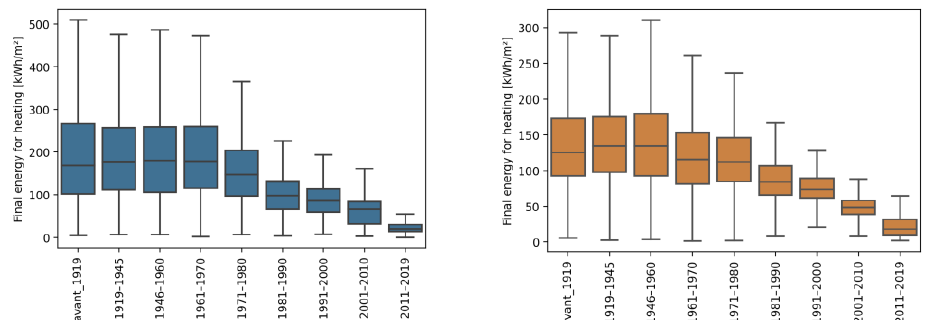
Figure 6. Spread of the final energy for heating of single-family and multi-family houses for each period of construction.